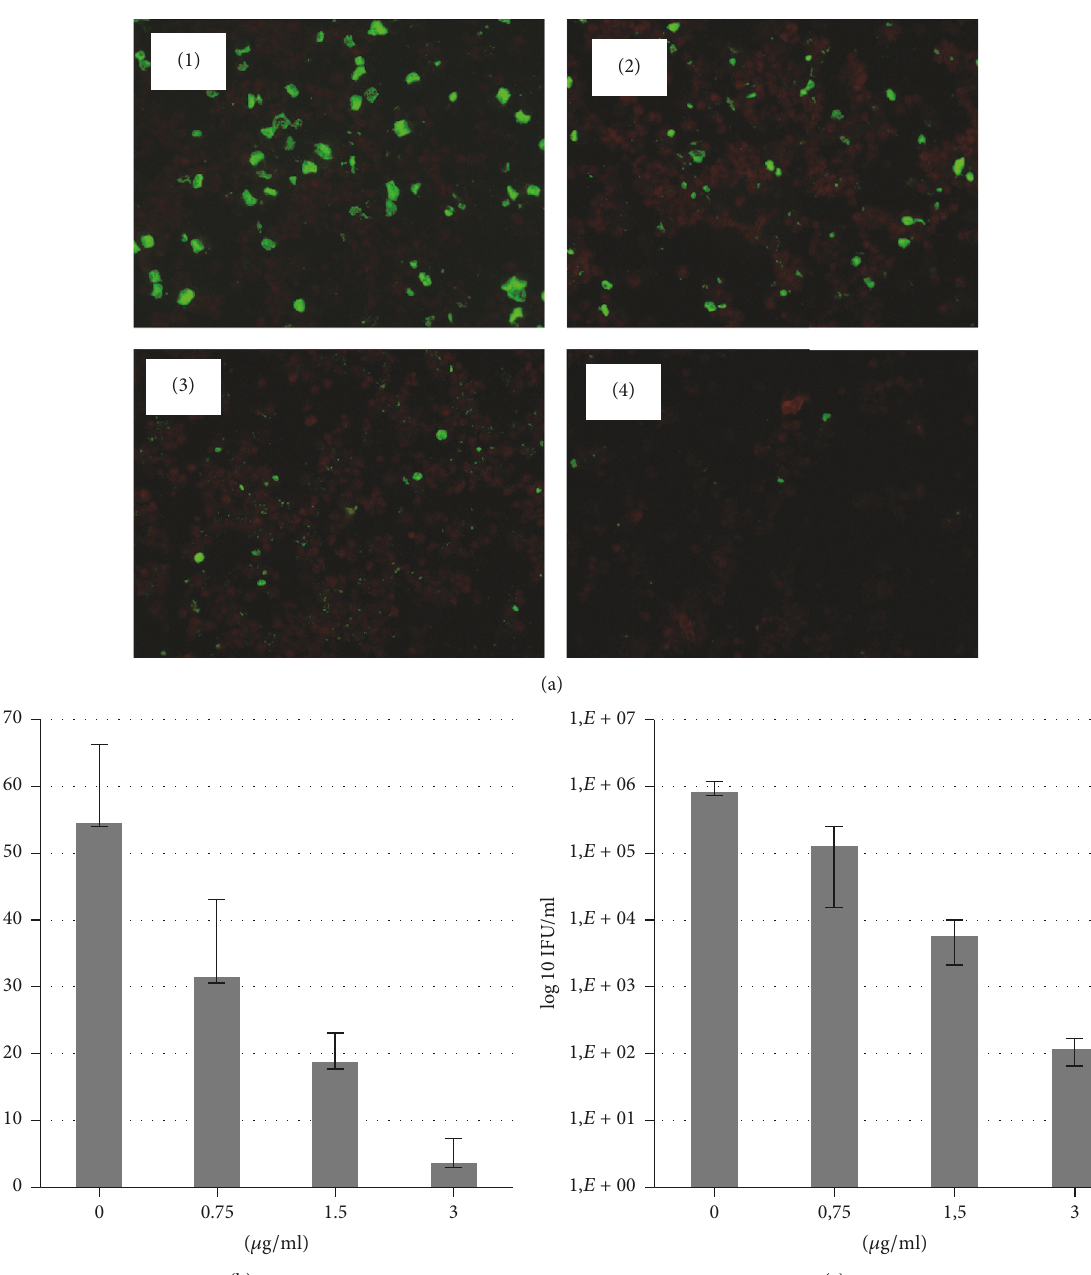
Figure 3: Dose-dependent inhibition of C. trachomatis growth in B10.MLM cells at 42 hpi in the presence of oil-formulated lycopene. (a) C. trachomatis infection in B10.MLM cells at 42 h.p.i. (1) growth in the presence of 0.015% olive oil in DMSO; (2) growth in the presence of 0.75 𝜇 g/ml; (3) 1.5 𝜇 g/ml; and (4) 3.0 𝜇 g/ml of oil-formulated lycopene. Scale bar 100 𝜇 m. (b) Quantitative representation of the inclusion numbers of control and lycopene treated cells. IFU/FOV = Average Inclusion Forming Units per Field of View ( 𝑛 = 20). (c) Infectious yield after treatment with different doses of